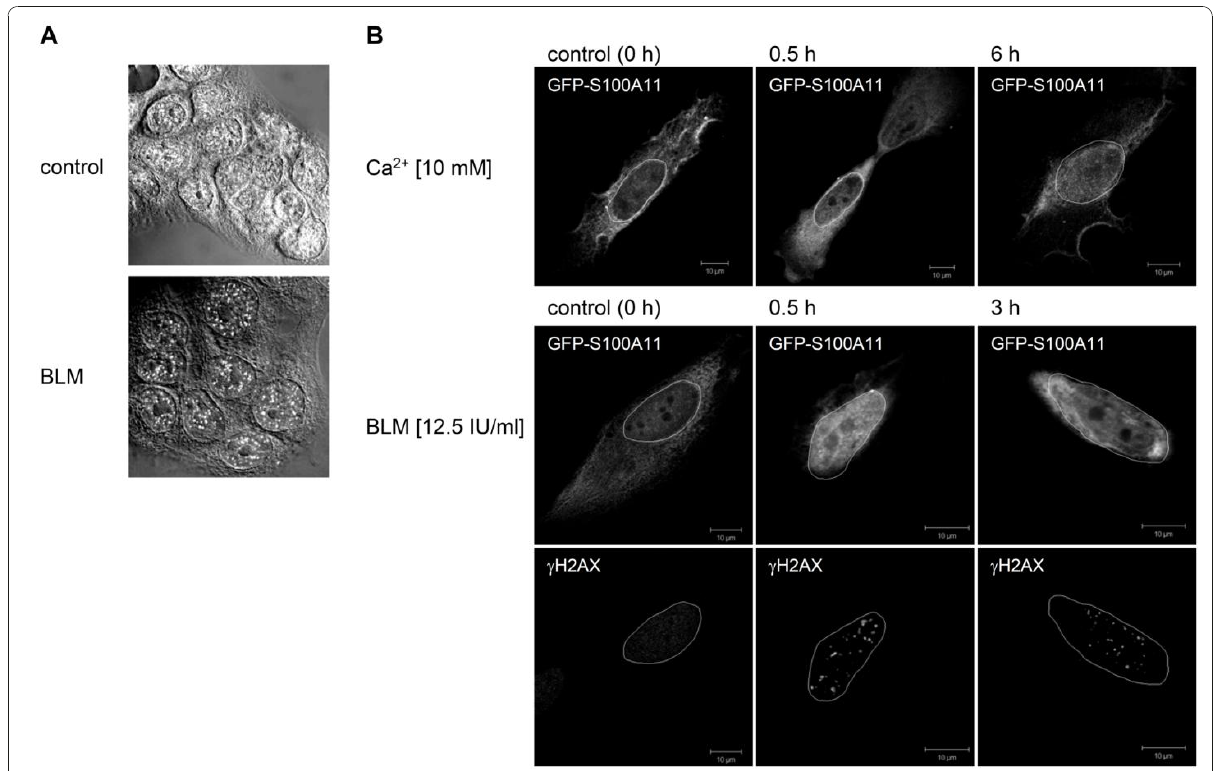
Figure 1 Translocation of S100A11 into the nucleus of human U-2 OS cells after stress stimulation . (A) Fixed human HaCaT keratinocytes treated with bleomycin (BLM) for 30 min were immunostained with anti-S100A11 antibody. In BLM treated cells decreased staining in the cytoplasm as well as increased staining in the nucelus can be observed. (B) U-2 OS cells transfected with GFP-S100A11 were treated with CaCl 2 (10 mM) or BLM (12.5 IU/ml), and analyzed by immunostaining followed by laser scanning microscopy for GFP-S100A11 and for g H2AX at different time points at